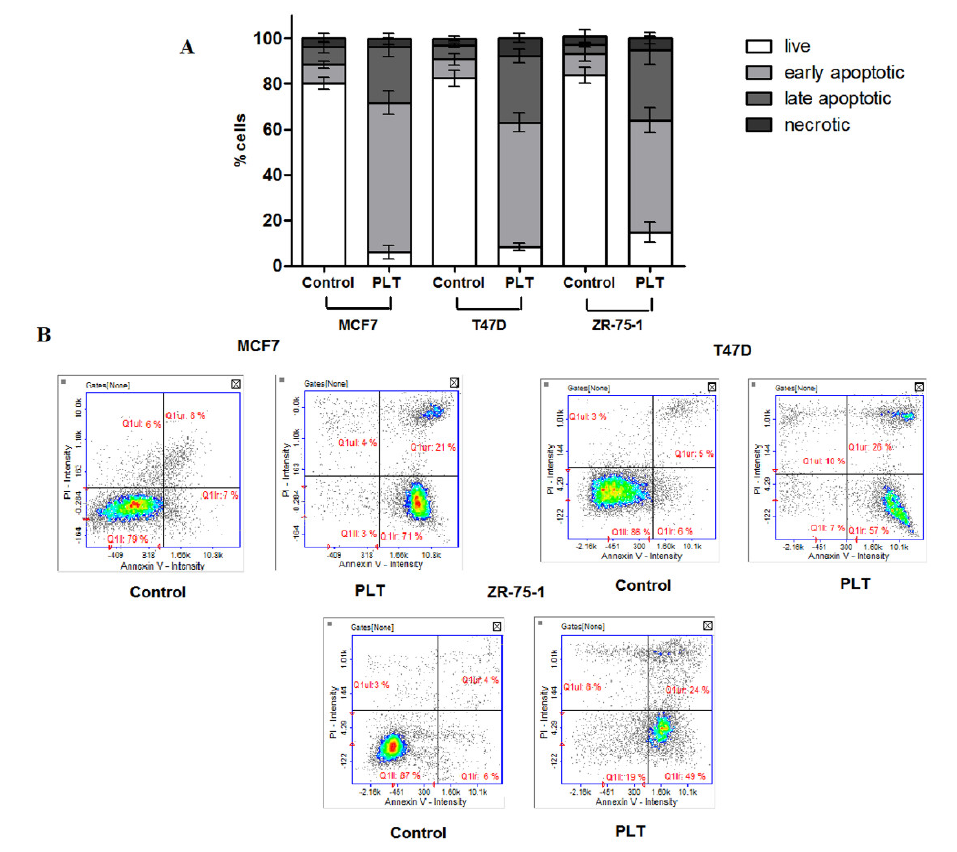
Figure 6. ( A ) Detection of cell apoptosis/necrosis in MCF7, T47D and ZR-75-1 cells with Annexin V-FITC and propidium iodide staining using image cytometry. The cells were treated for 72 h at the IC 50 -specific PLT concentration. Values were presented as mean ± SD derived from three independent experiments. ( B ) The results show one representative experiment of three independently performed. Q1II-live, Q1lr- early apoptotic, Q1ur- late apoptotic, and Q1uI- necrotic cells.